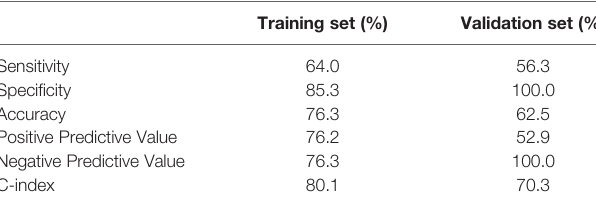
TABLE 5 | Information of prediction performance.